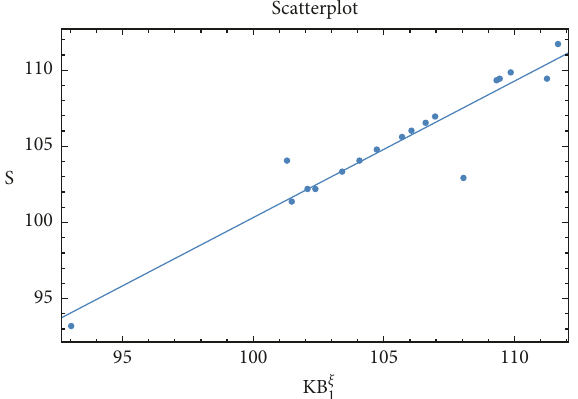
Figure 5: Scatter diagram of S on H regression line.